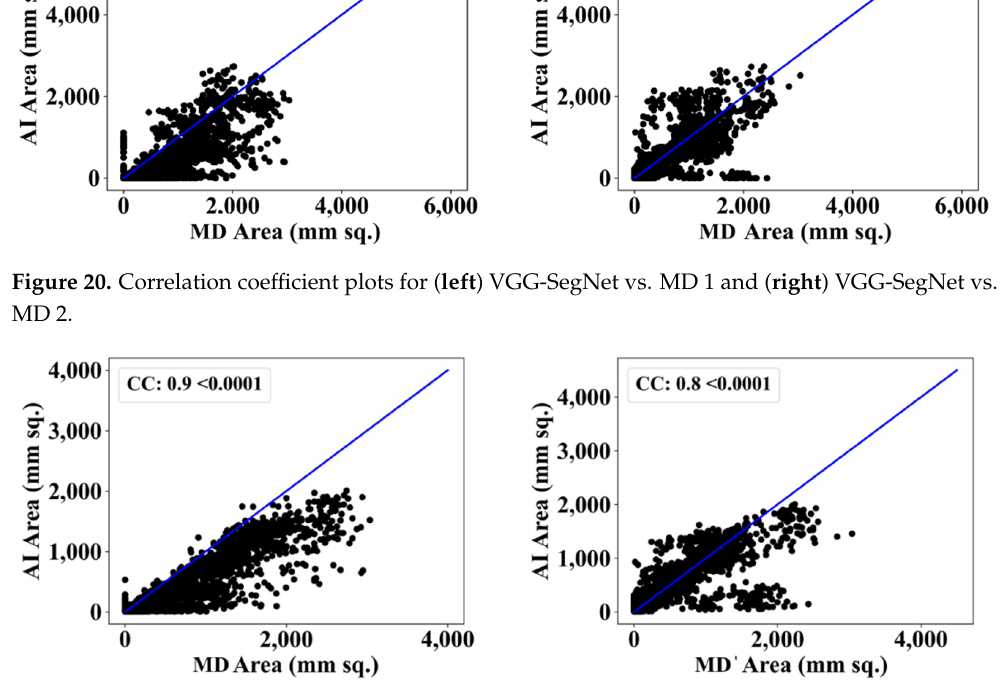
Figure 21. Correlation coefficient plots for (left) ResNet ‐ SegNet vs. MD 1 and (right) ResNet ‐ SegNet vs. MD 2.